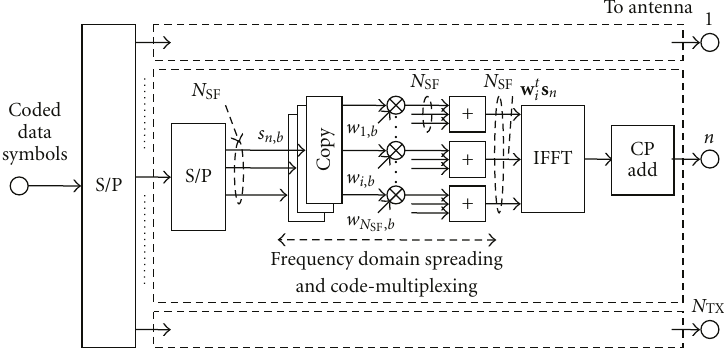
Figure 1: Block diagram of the OFDM MIMO transmitter using frequency domain spreading and code multiplexing.